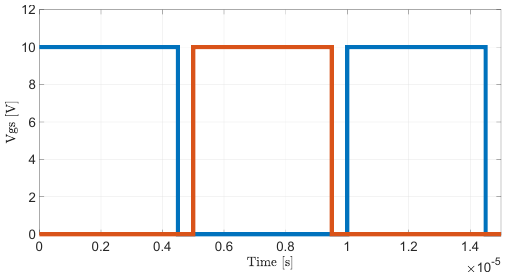
Figure 16. The gate to source voltages to the